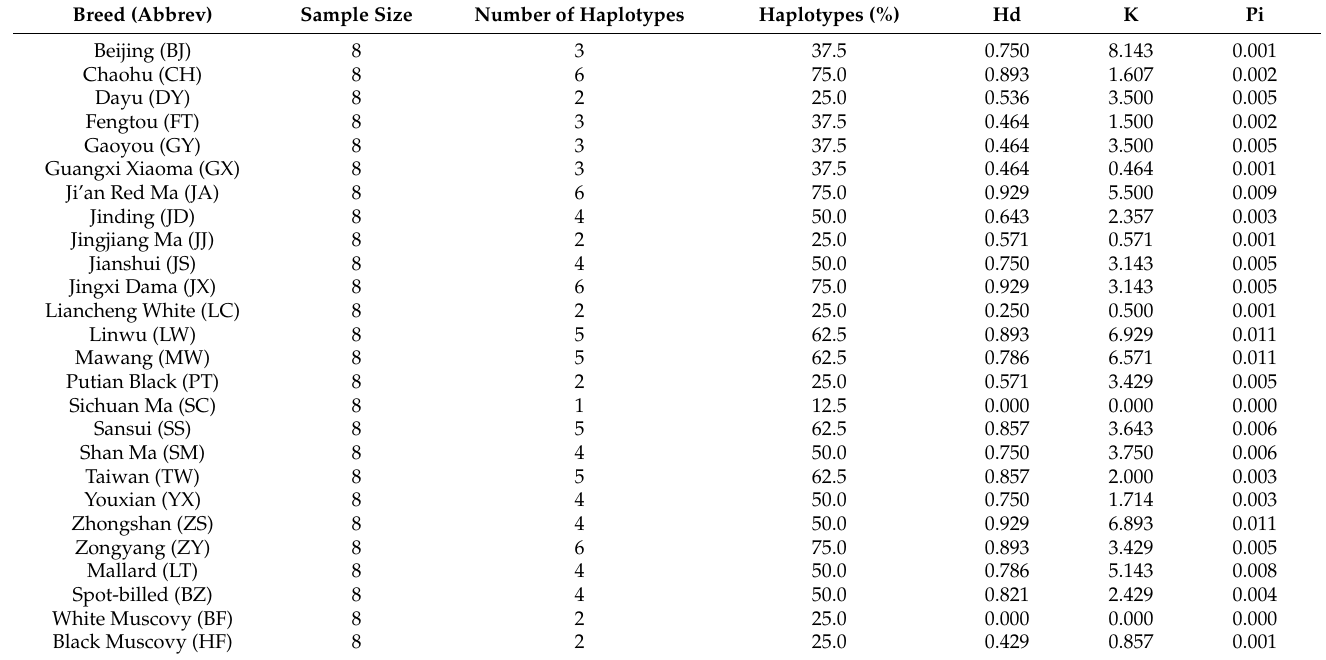
Table 3. Haplotype diversity (Hd), average number of differences (K), and nucleotide diversity (Pi) of the control region of mtDNA in 26 duck populations.